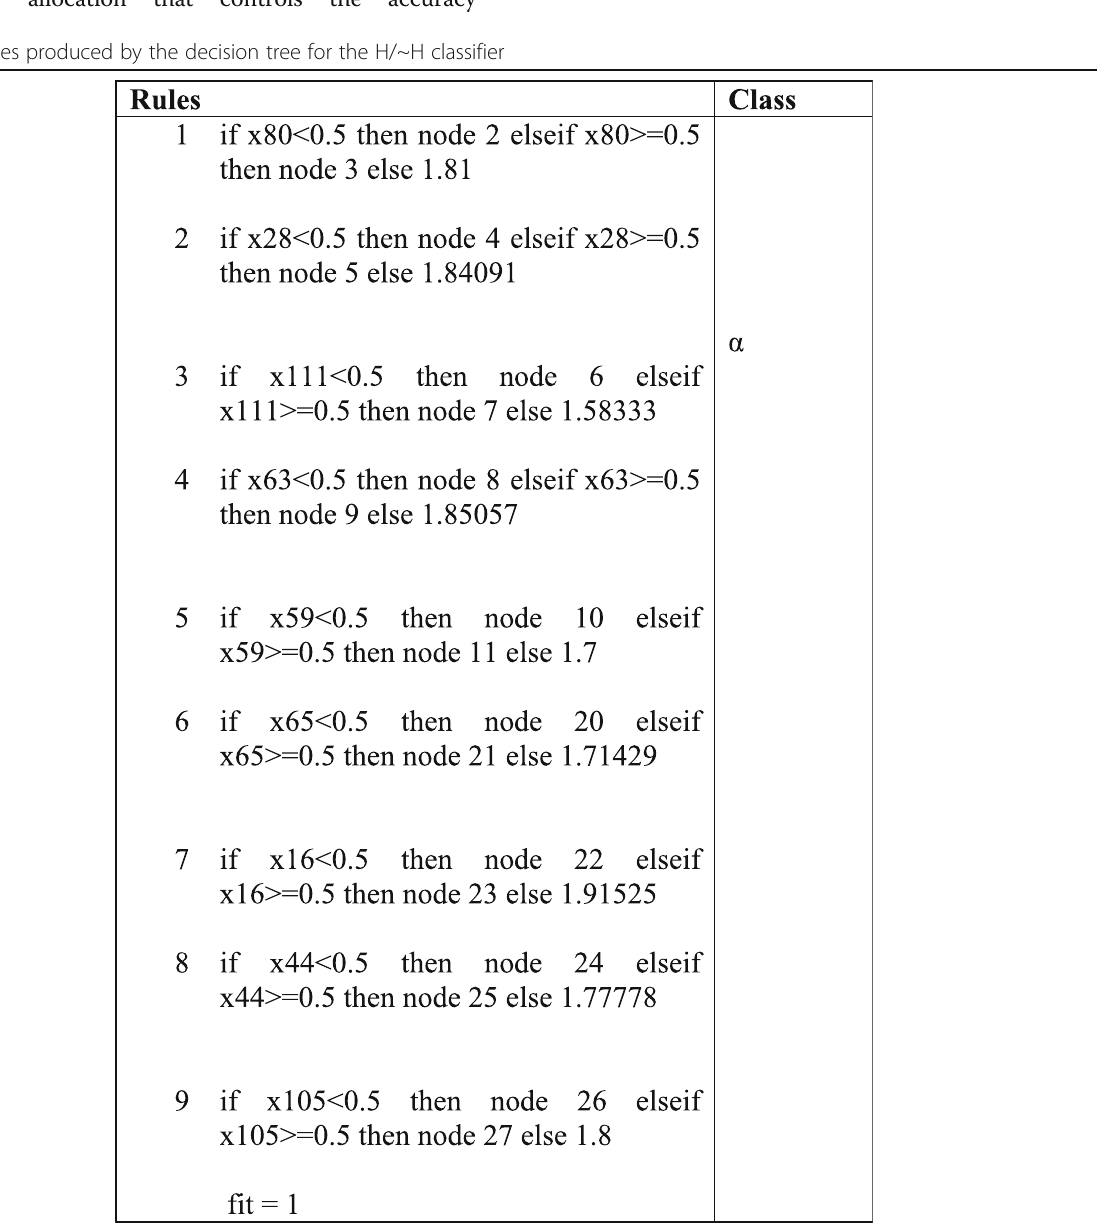
Table 4 Rules produced by the decision tree for the H/~H